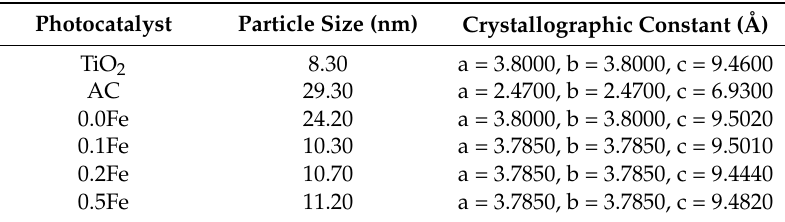
Table 2. Particle size of the composite